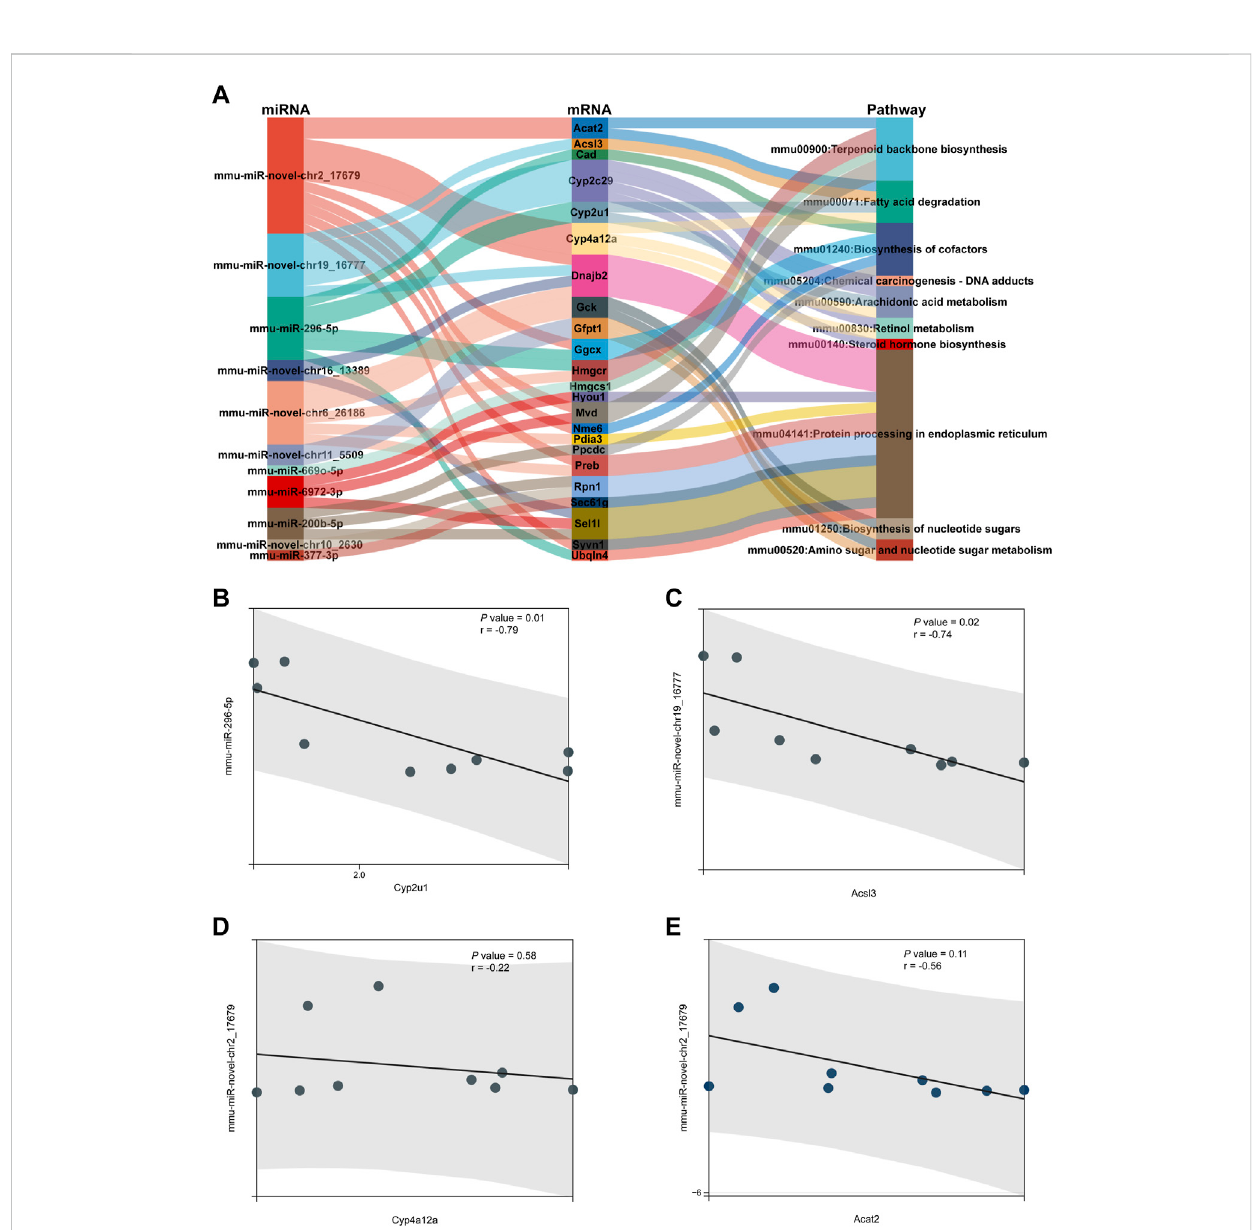
FIGURE 8 miRNA – mRNA-pathway regulation analysis. (A) Sankey diagram was established under joint relation between miRNA – mRNA and mRNA-pathway involved in metabolism. (B – E) Scatter plot showing the miRNA – mRNA pairs that participated in lipid metabolism. (B) Correlation between mmu-miR- 296-5p and Cyp2u1. (C) Correlation between mmu-miR-novel-chr19_16777 and Acsl3. (D) Correlation between mmu-miR-novel-chr2_17679 and Cyp4a12a. (E) Correlation between mmu-miR-novel-chr2_17679 and